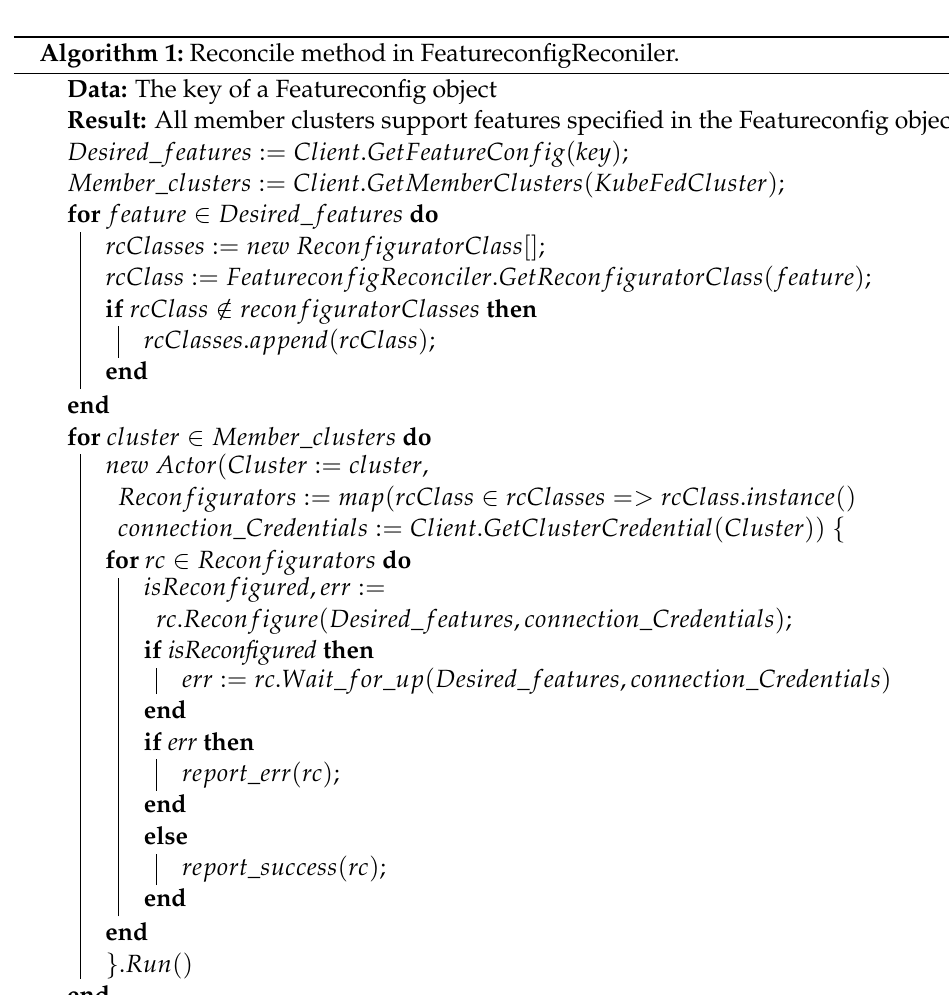
Algorithm 1: Reconcile method in